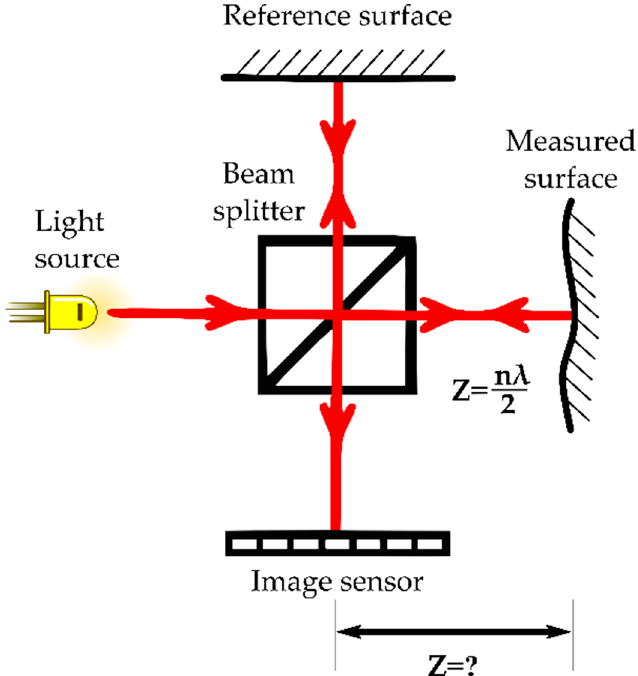
Figure 4. Schematic representation of a Michelson interferometer where the relative depth “ Z ” is directly proportional to the wavelength of the light source “ λ ” and to the number of fringes “ n ”.